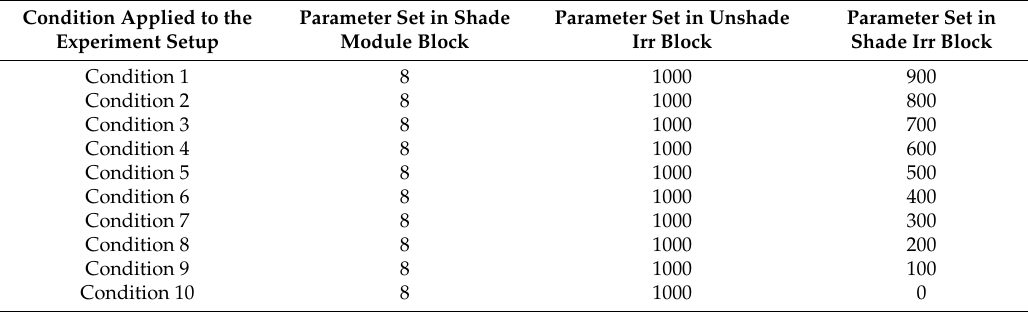
Table 3. Parameters set in the model shown in Figure 7 to conduct the experiment for the 8 modules shaded setup.